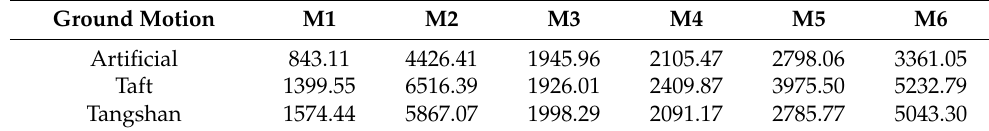
Table 11. The peak base shear of six models under the ground motions. (unit: kN).